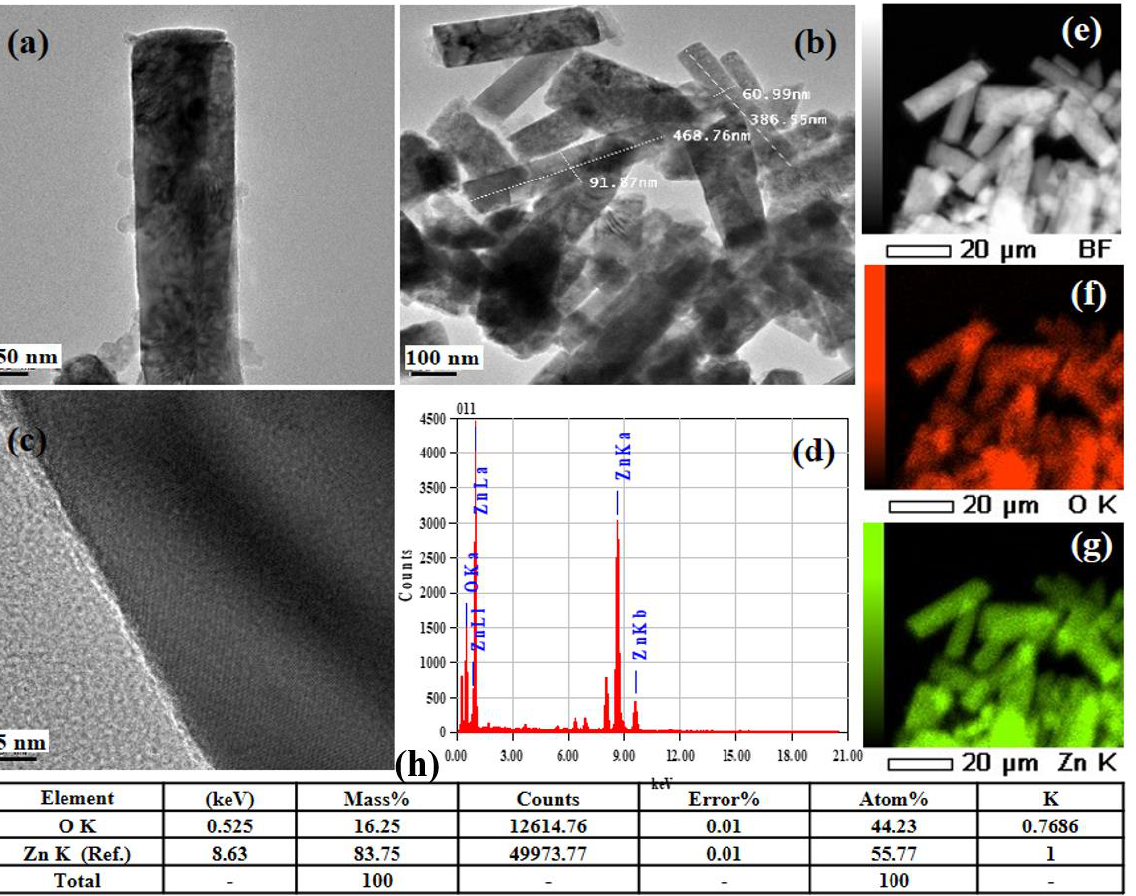
Figure 6. ( a , b ) TEM images, ( c ) HRTEM images, ( d ) EDX spectra of the ZNRAs-8h (Inset: EDX analyses for elemental composition), and ( e – h ) EDX